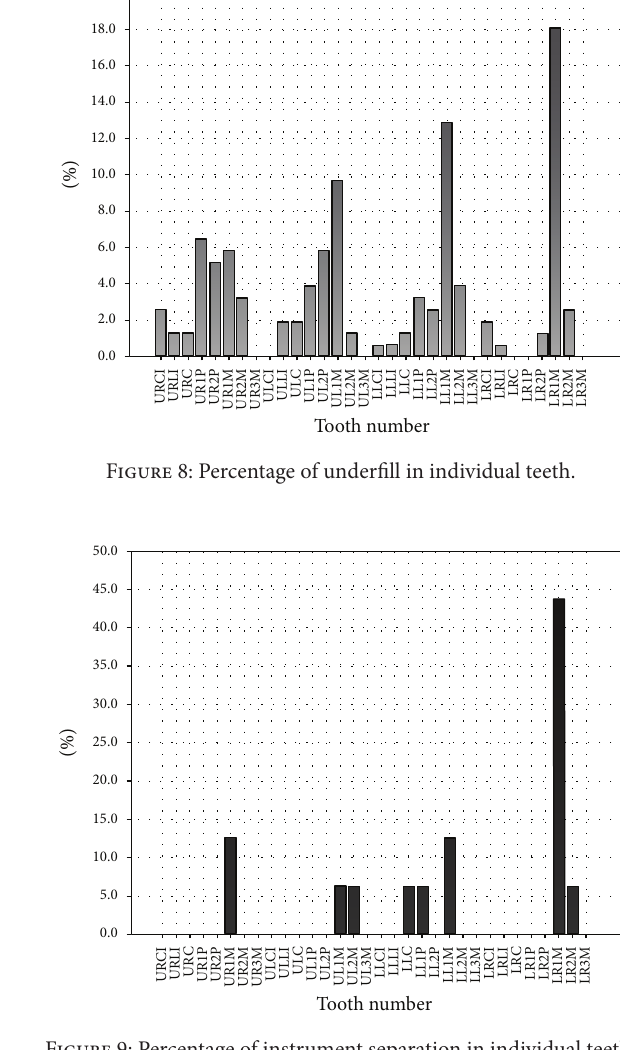
Figure 9: Percentage of instrument separation in individual